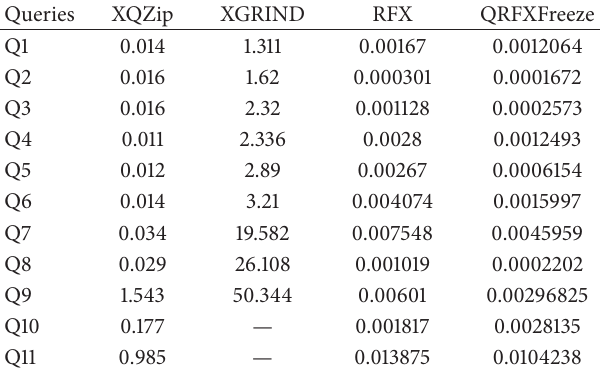
Table 3: Query execution time in seconds on various queryable compressors.